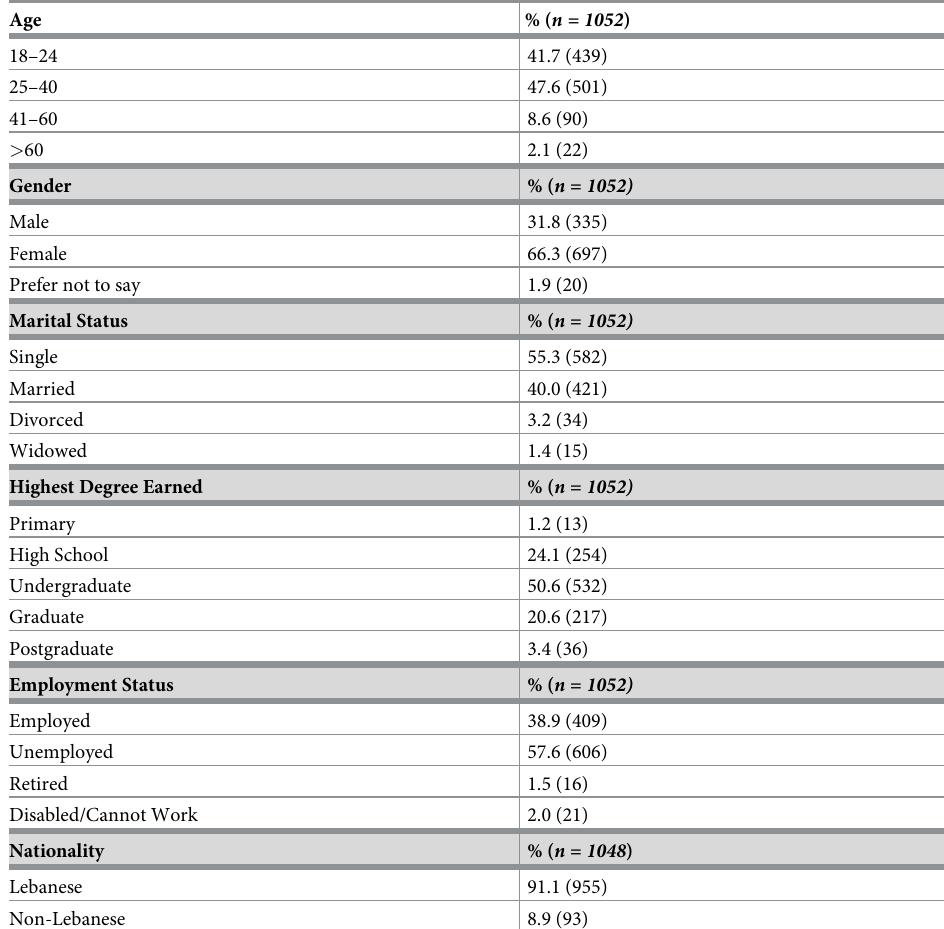
Table 1. Socio-demographic information of